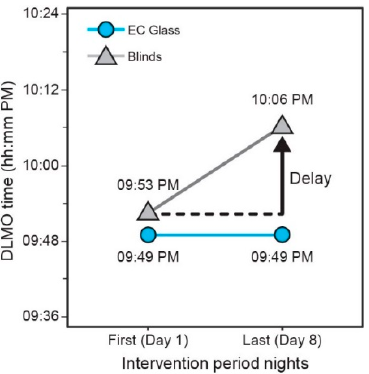
Figure 6. Unadjusted DLMO shift from the first (Day 1) to the last (Day 8) day of each intervention period. Table 5. Results of the linear mixed-effects model of condition and dim light melatonin onset.